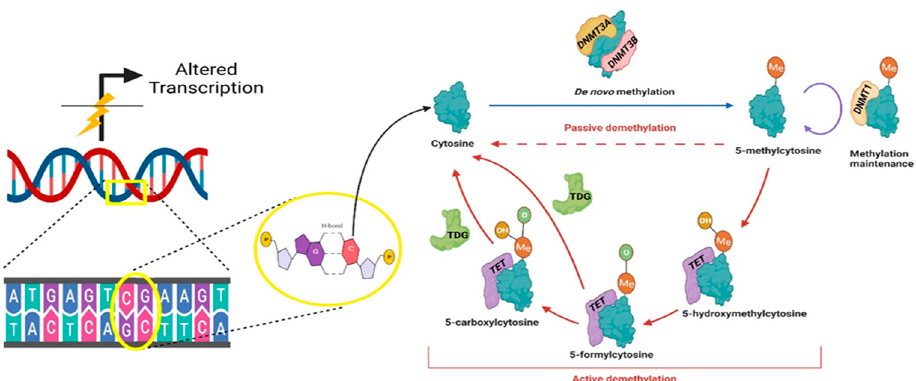
Figure 3. Mechanism of DNA methylation at position 5 of cytosines present within a CG dinucleotide site (CpG). Enzymes responsible for DNA methylation, passive demethylation and stepwise active demethylation processes are depicted (DNMT = DNA Methyl Transferases; TET = Ten-eleven Translocation enzymes; TDG = Thymine DNA Glycosylase). Created with BioRender.com, accessed 29 May 2021.